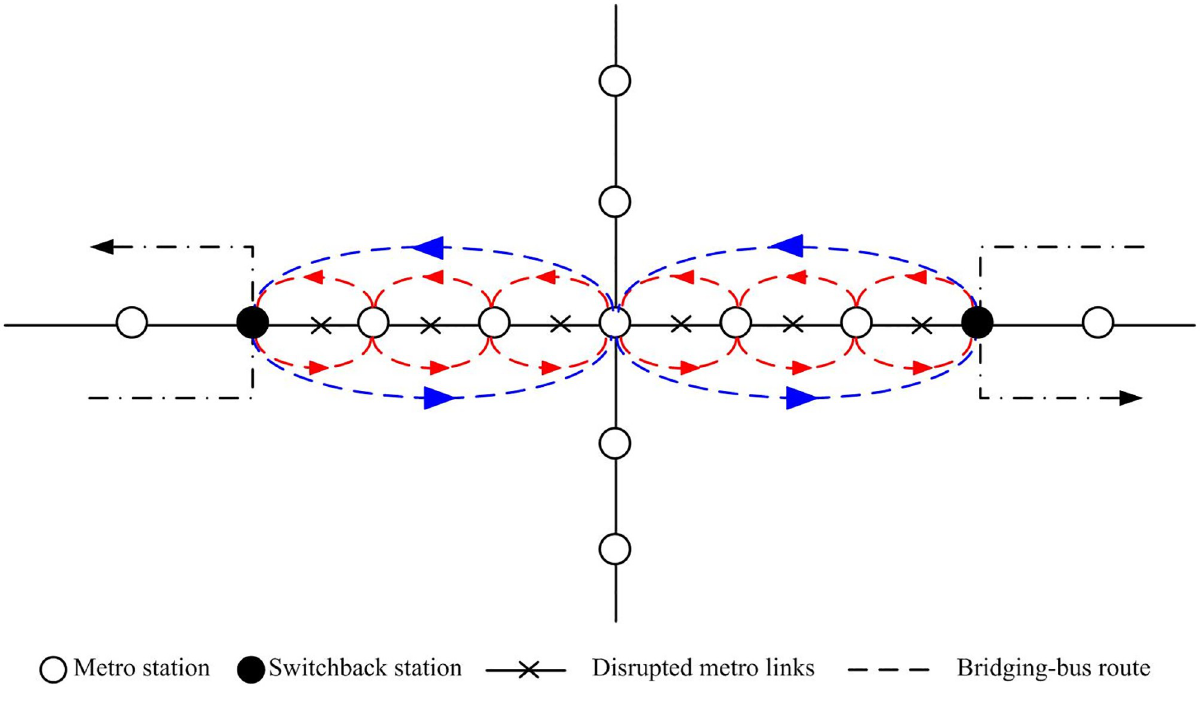
Fig 1. Schematic of metro network disruption and bus bridging response